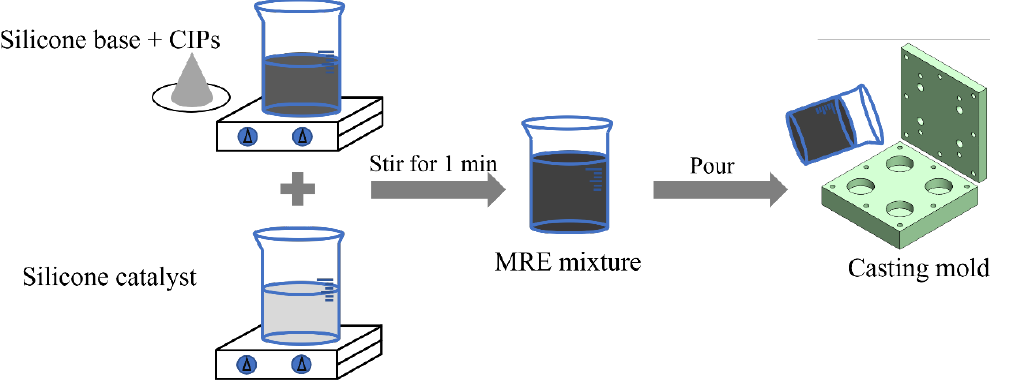
Figure 2. Schematic diagram of MRE fabrication process. Table 3. Composition and labels of the fabricated MREs.